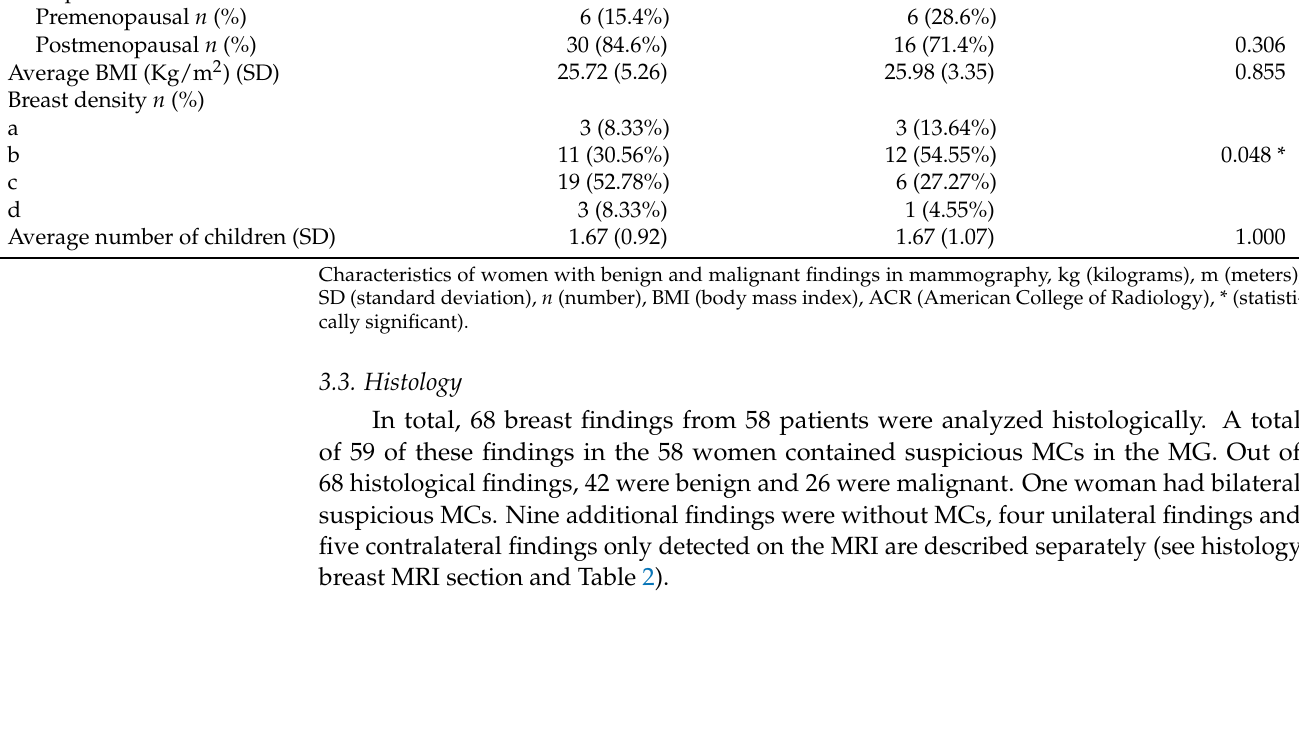
Table 1. Characteristics of women with benign and malignant findings in mammography .